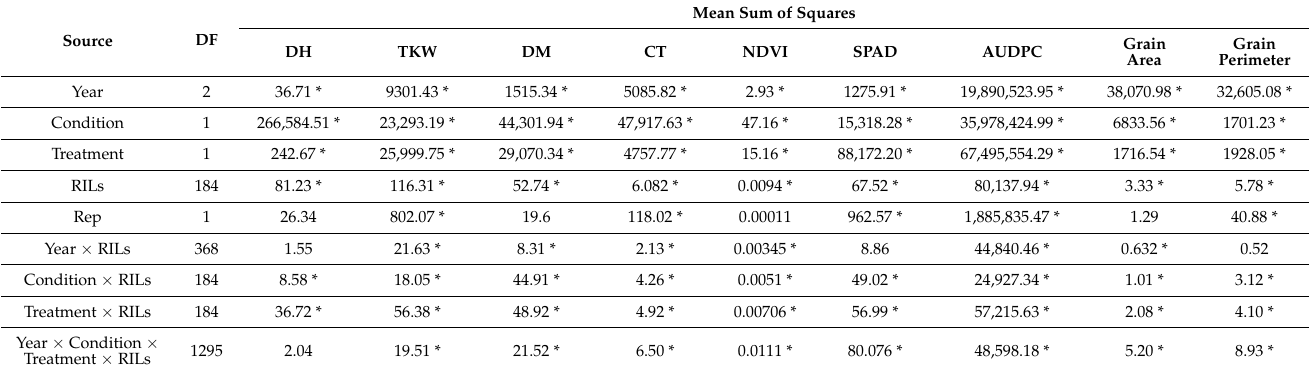
Table 2. Analysis of variance for nine traits during the interaction of various treatments and environ- ments